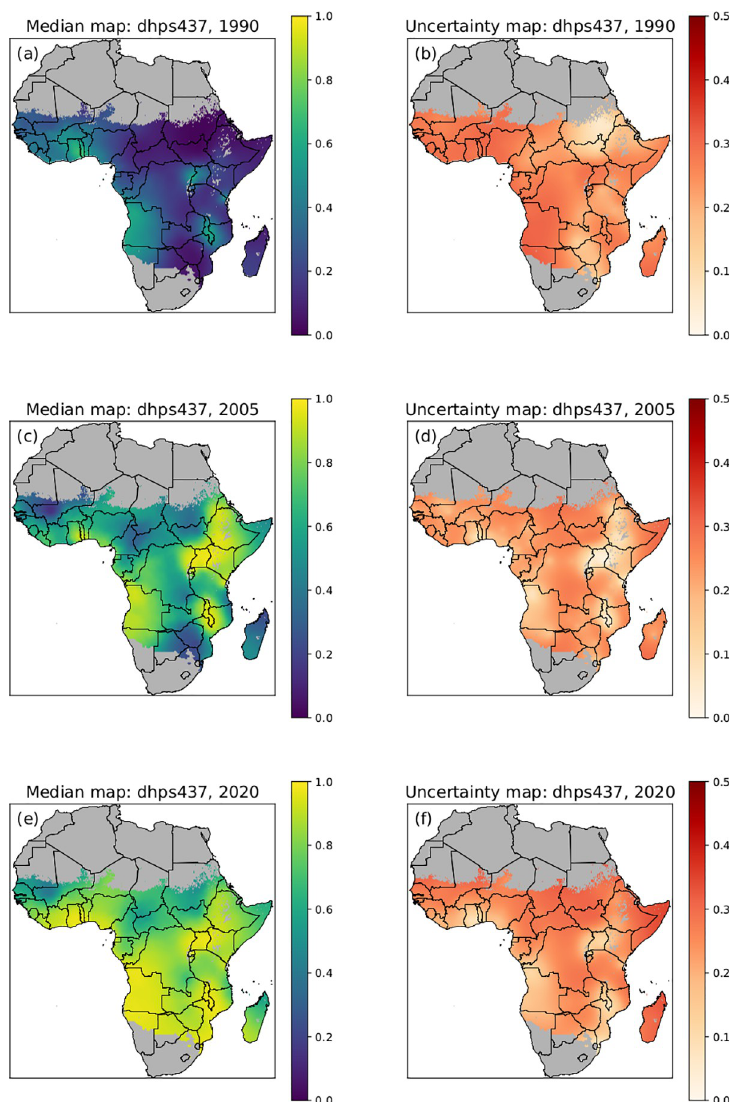
Fig 2. Posterior predictive median prevalence of pfdhps 437G. Posterior predictive median prevalence of pfdhps 437G in 1990 (a), 2005 (c) and 2020 (e). Associated standard deviations (uncertainty) for pfdhps 437G posterior predictions in 1990 (b), 2005 (d) and 2020 (f). A low standard deviation (lighter colour) indicates low uncertainty and high confidence in the model. National shapefiles were obtained from the Malaria Atlas Project (MAP;